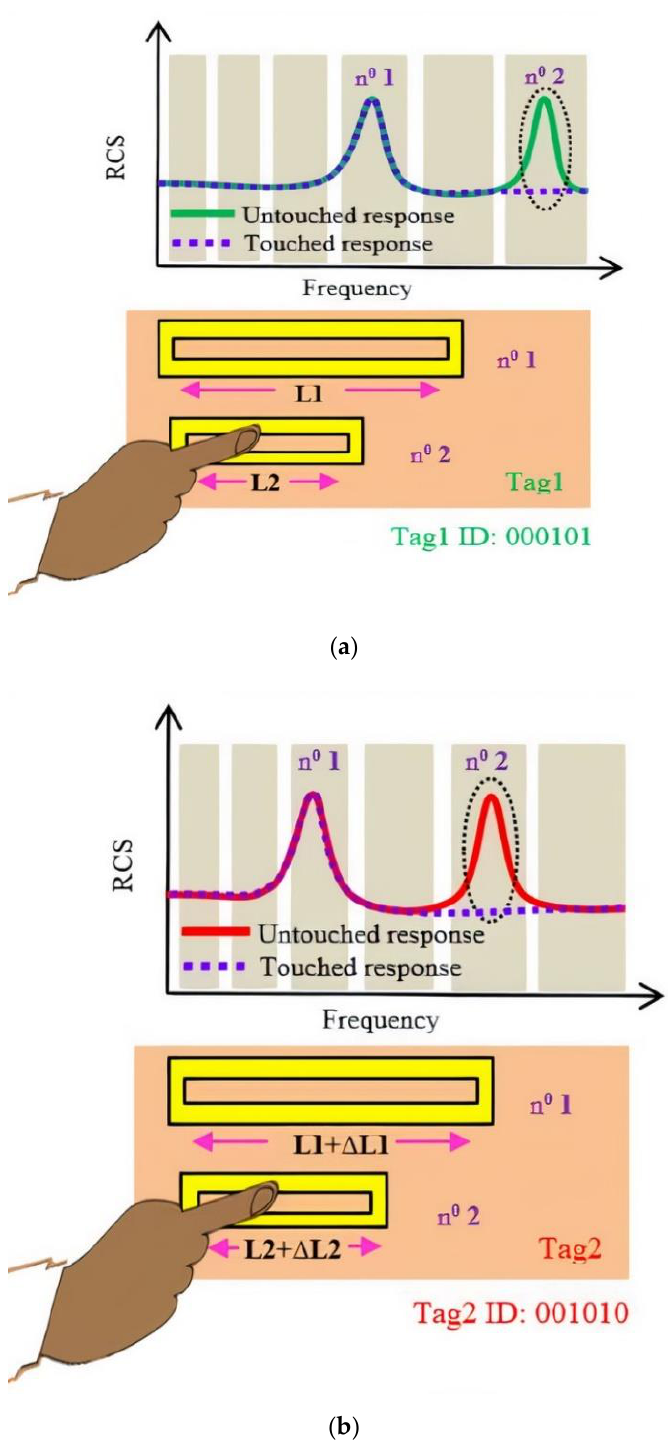
Figure 3. Wireless Numeric keypad technique applied for the tags mentioned in Figure 2: ( a ) Tag1; ( b ) Tag 2.